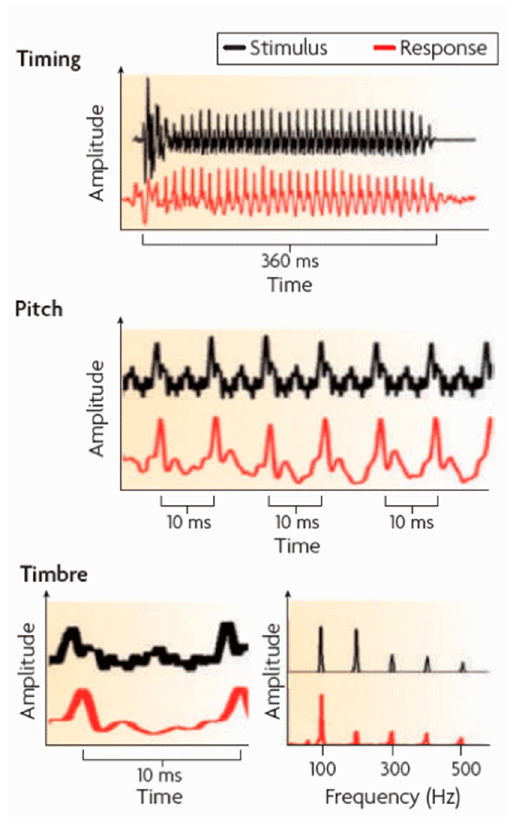
Figure 1. Auditory evoked neural response to temporal characteristics, frequency, and spectral features as the representations of timing, pitch, and timbre in the human auditory brainstem, depicted as changes in amplitude across time ( top, middle and bottom left ) and as spectral amplitude across frequency ( bottom right ). Adapted with permission from Ref. [75]. (Copyright 2010 Nature Publishing Group, Macmillan, Berlin, Germany; License number: 5213020142320).